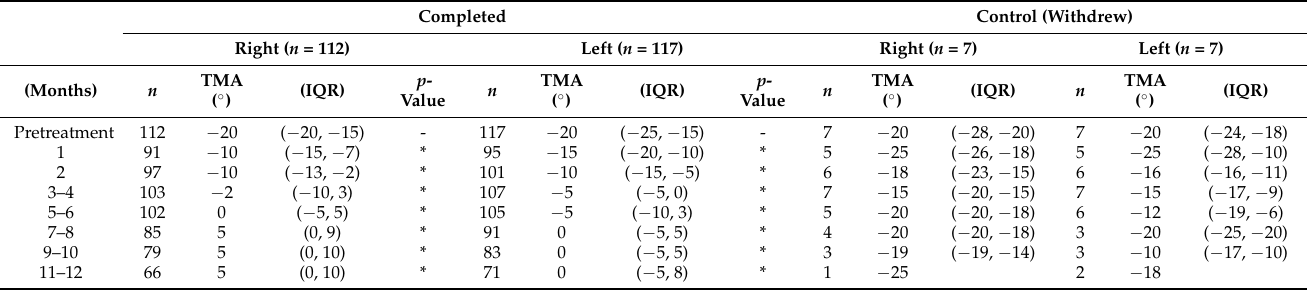
Table 2. Change in the TMA from pretreatment to 12 months after treatment.